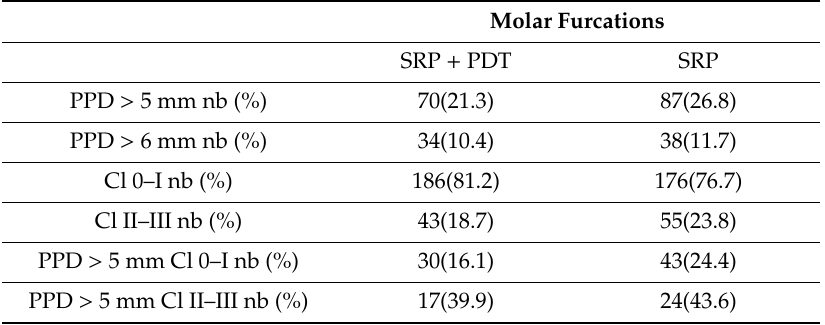
Table 3. Characteristics of molar furcations at baseline in SRP + PDT and SRP